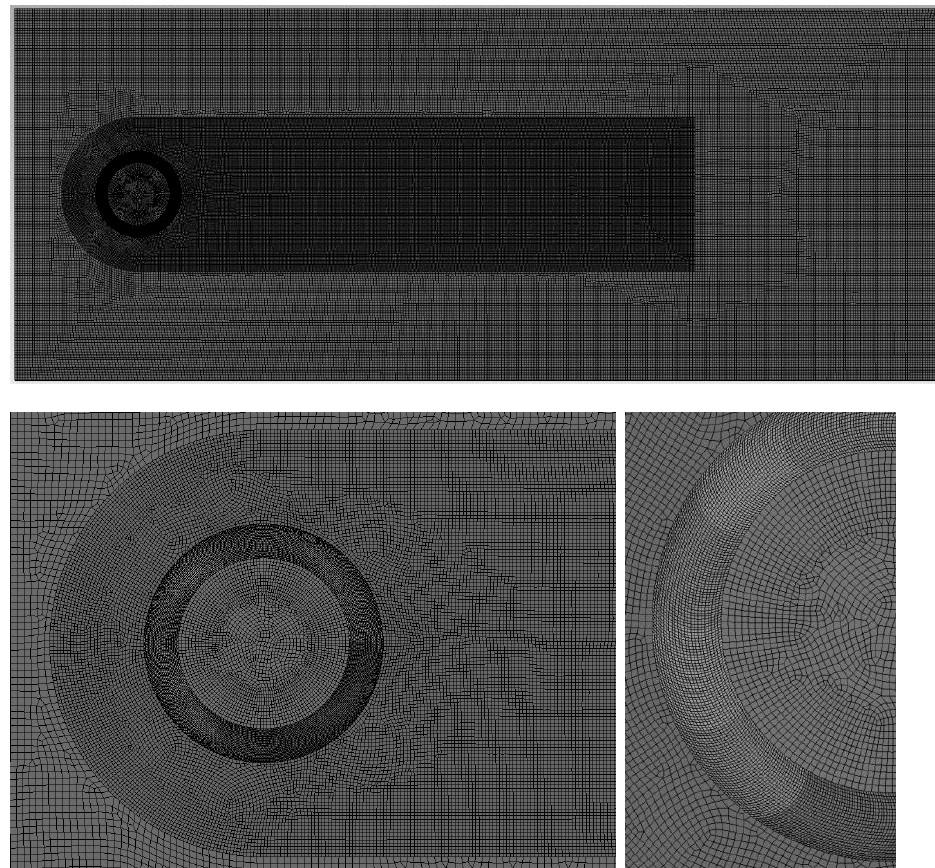
Figure 3. Spatial discretisation of the flow domains.